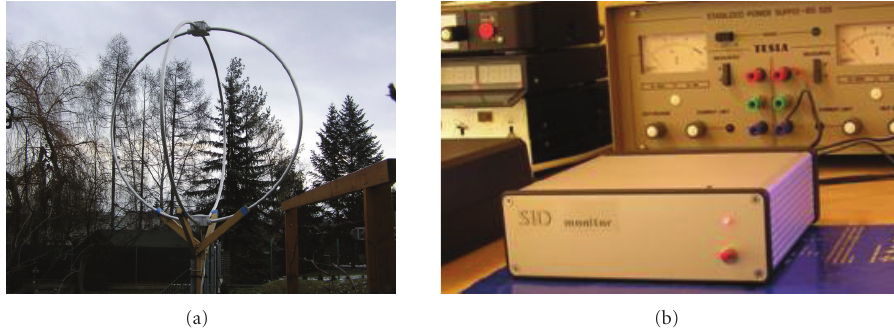
Figure 13: The loop antenna (size 75 × 75 cm) and a 2-channel radio VLF receiver used for SID detection of GRBs.